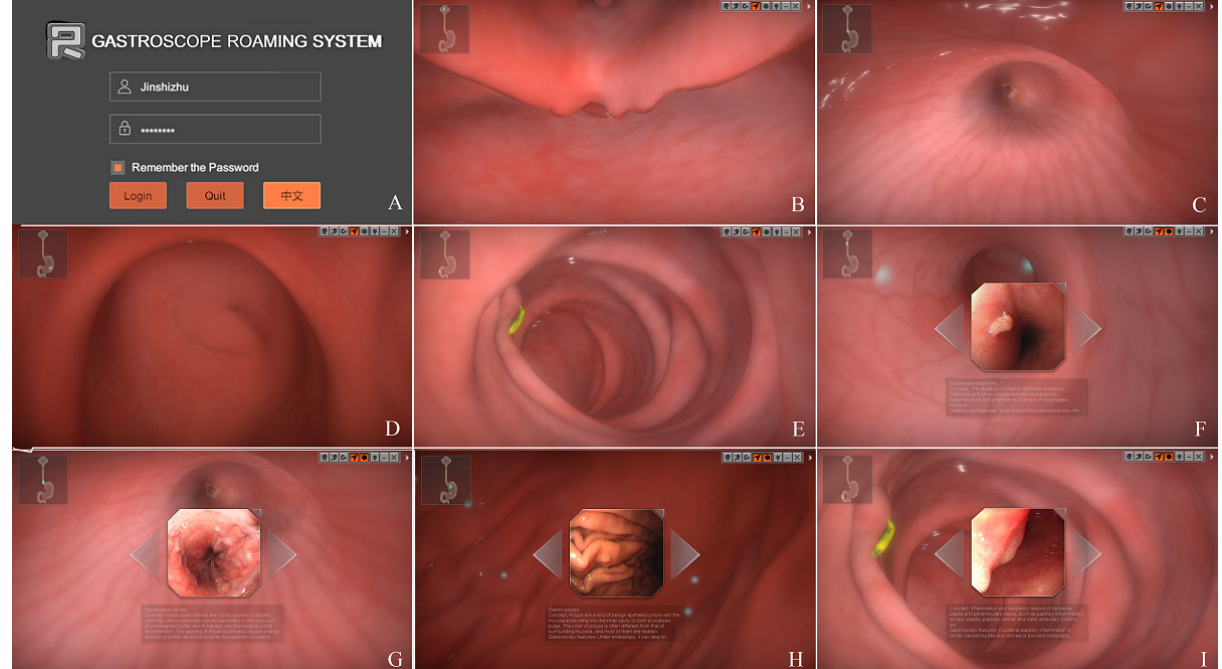
Figure 1. Gastroscope Roaming System’s software screen captures. (A) Software system log-in interface. (B) Normal esophageal entrance screenshot. (C) Normal cardia entrance screenshot. (D) Normal pyloric entrance screenshot. (E) Normal duodenal papilla screenshot. (F-I) Screenshots of